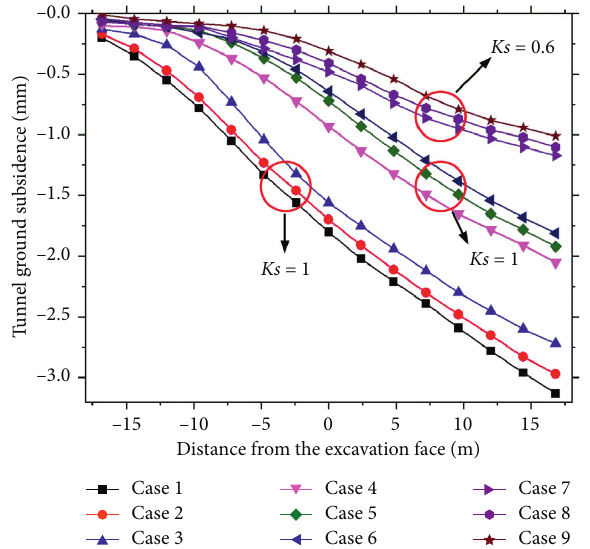
Figure 16: Settlement of measuring point B of the adjacent building under different working